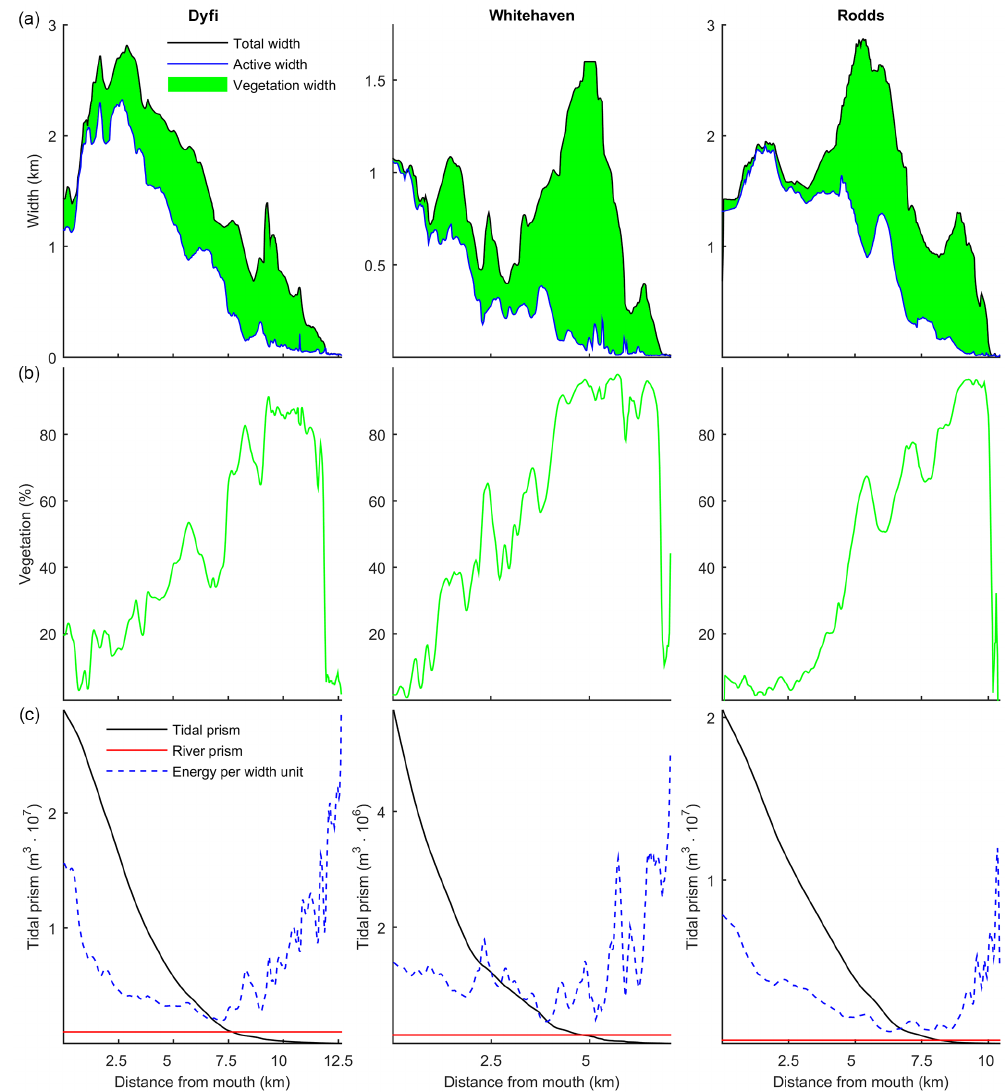
Figure 12. (a) The total, active and marsh width along three natural estuaries, partitioned by the method of Leuven et al. (2017). (b) The vegetated part as a percentage of the total width. (c) Tidal prism, discharge and energy taken as width-averaged tidal prism (for method, see Leuven et al.,